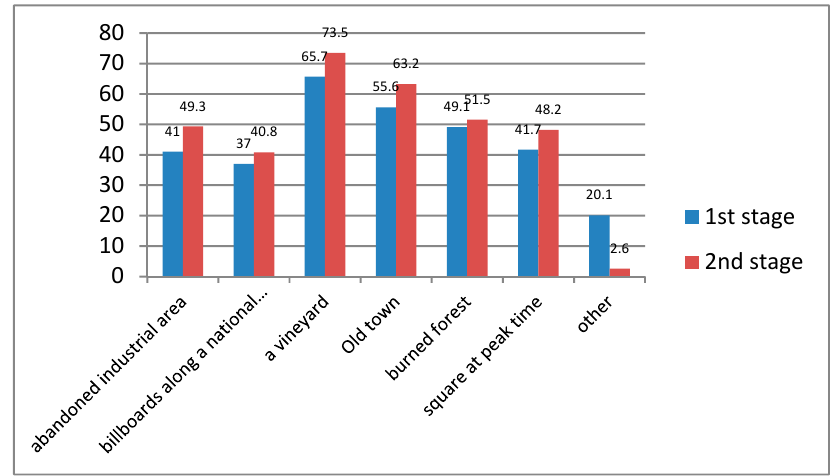
Figure 2. Greek engineering student landscape perception change, in answer to the question “do you consider these as landscapes or not?”.